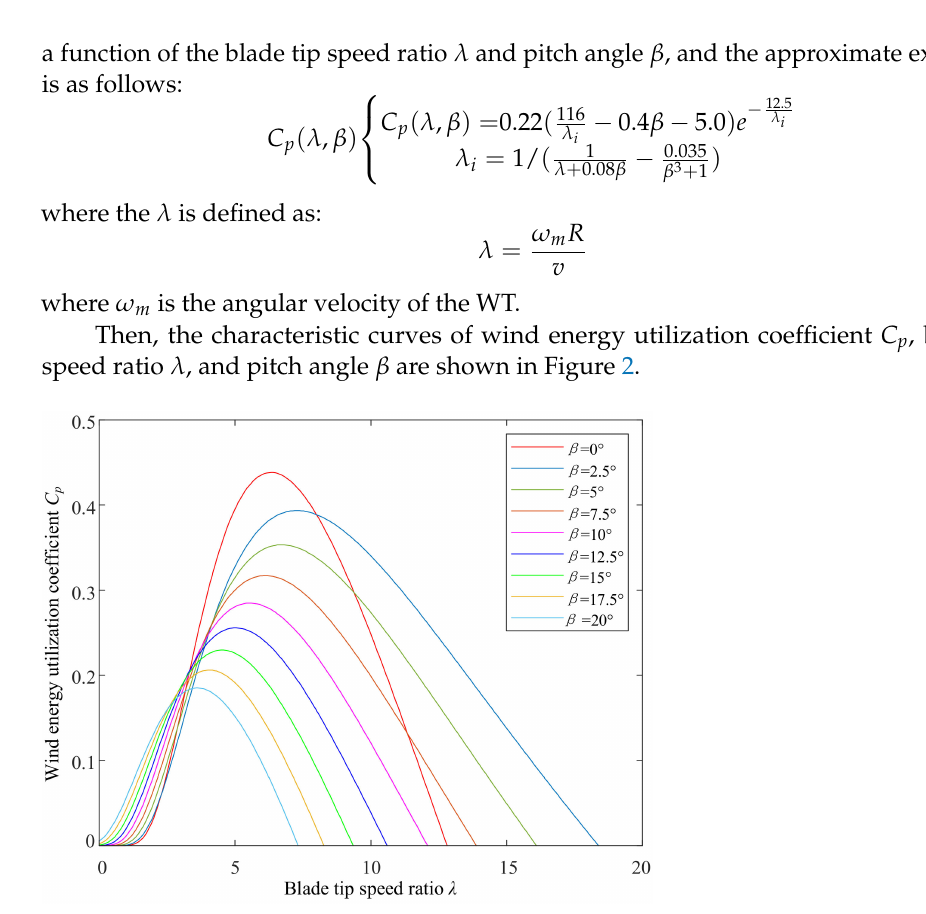
Figure 2. The characteristic curves of wind energy utilization coefficient, blade tip speed ratio, and a pitch angle.